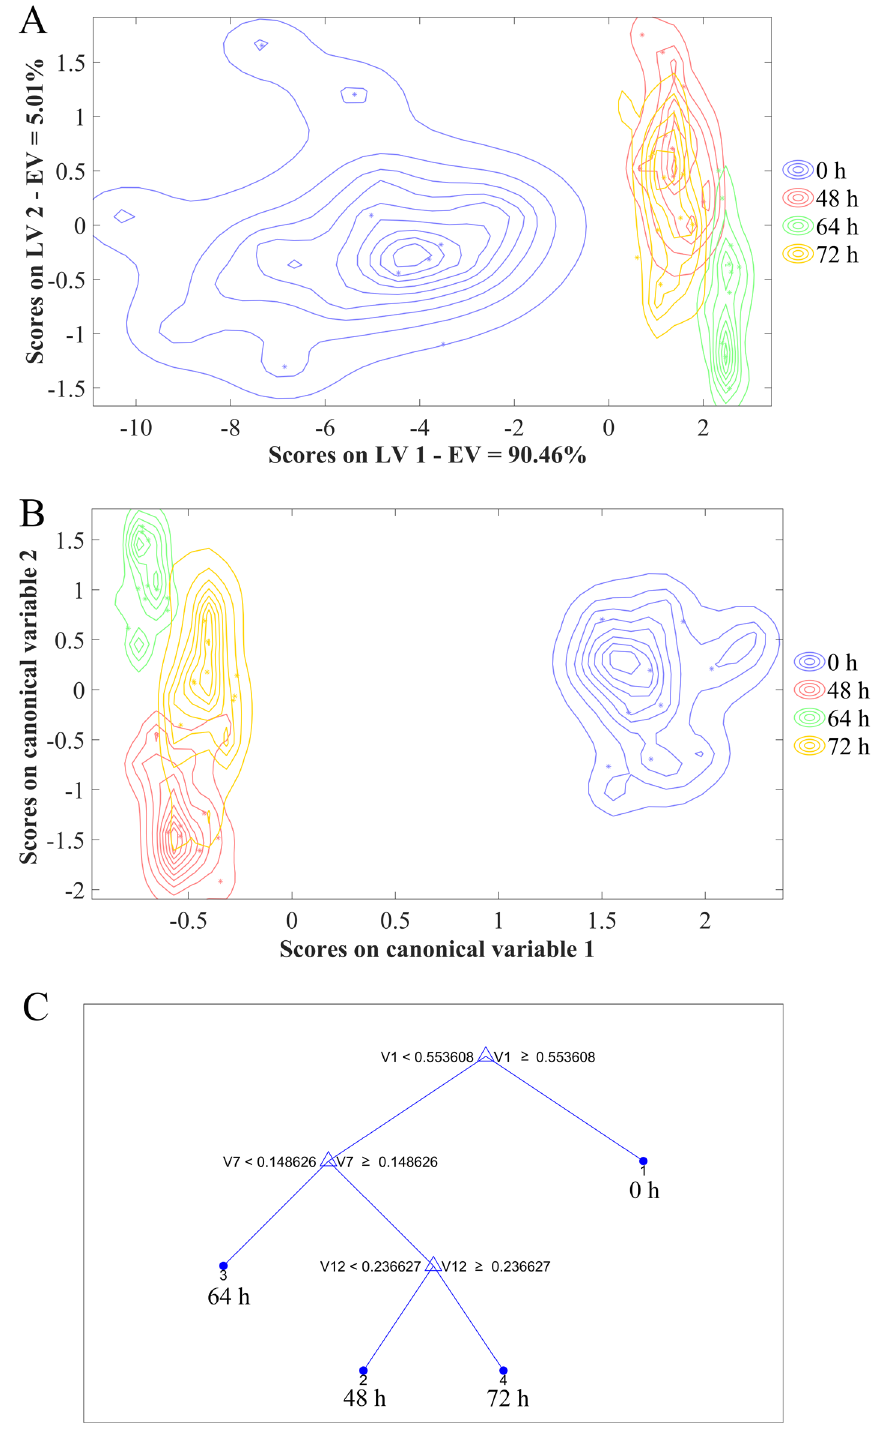
Figure 9. Three discriminant models of C. fimbriata -infected sweetpotatoes at 0 h, 48 h, 64 h, and 72 h. ( A ) PLS-DA. ( B ) LDA. ( C ) CART. Solid circles in ( A ) and ( B ) represent the calibration set; the symbol * represents the prediction set.